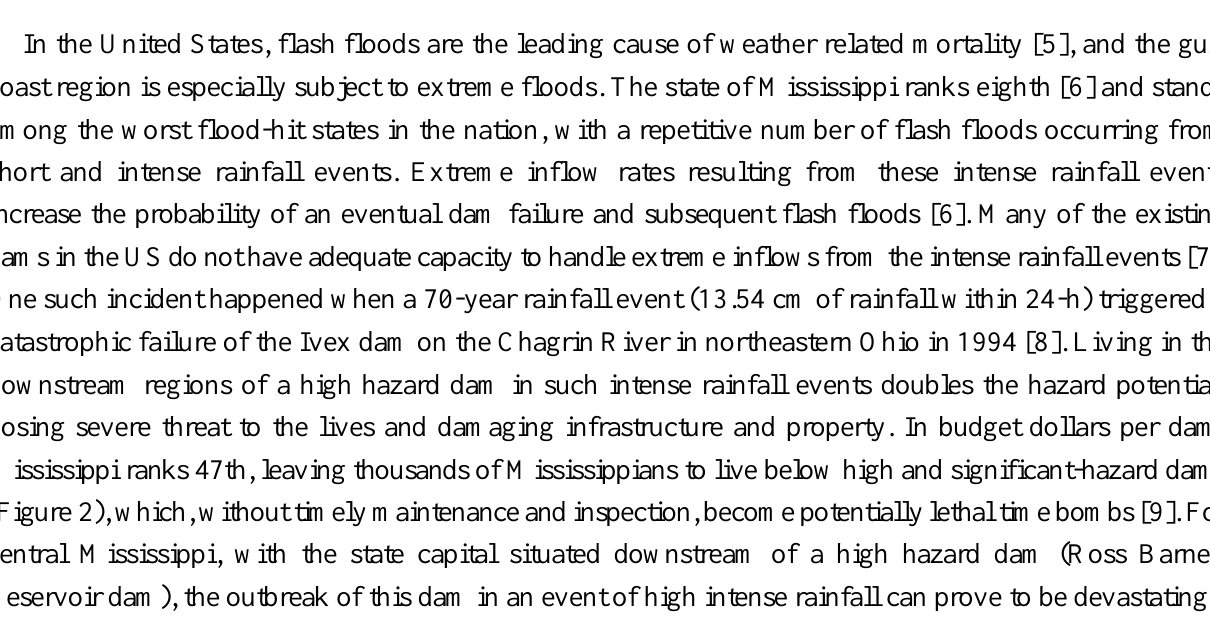
Figure 2. Spatial location of high hazard dams in the State of